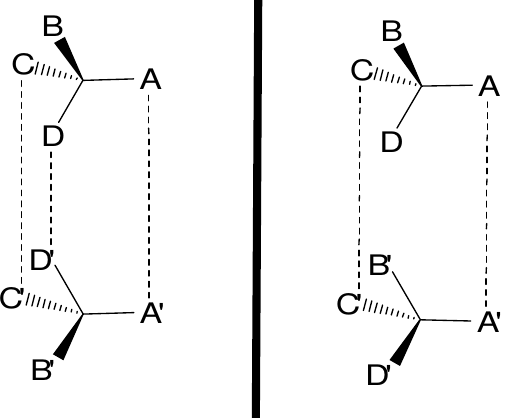
Figure 7. The three-point interaction model. With one enantiomer three interactions are established, but only two are possible with the other enantiomer. The third interaction D-D’ determines the degree of